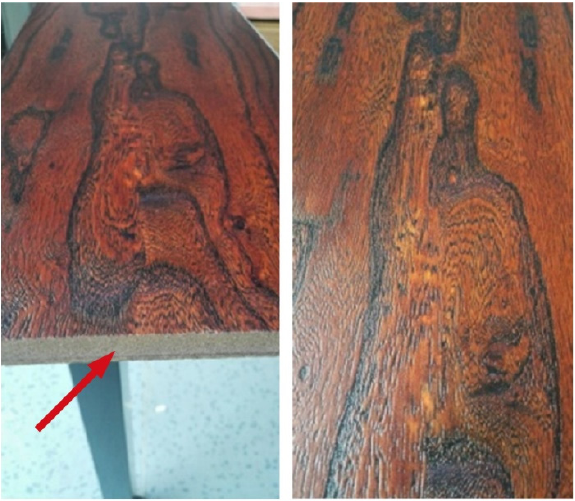
Figure 7. Elm texture 3D printed on medium-density fiberboard (MDF) substrate [66].